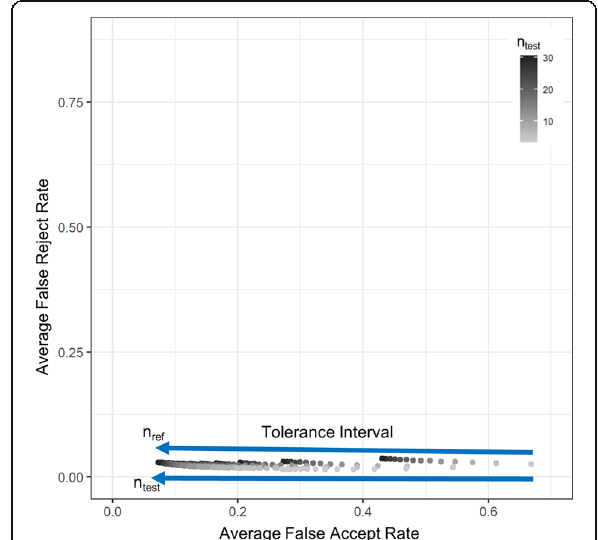
Fig. 3 Sample size dependency of average operating characteristics: The average operating characteristics are shown for different test and reference product sample sizes (n ref = 4,6,8,...,30, n test = 4,6,8,...30) for the tests MinMax, 3Sigma and equivalence testing of means. Arrows indicate the effect of increasing test product and reference product sample size (annotated as n test and n ref , respectively). The grey background polygons accentuate the area of operating characteristics for the individual tests